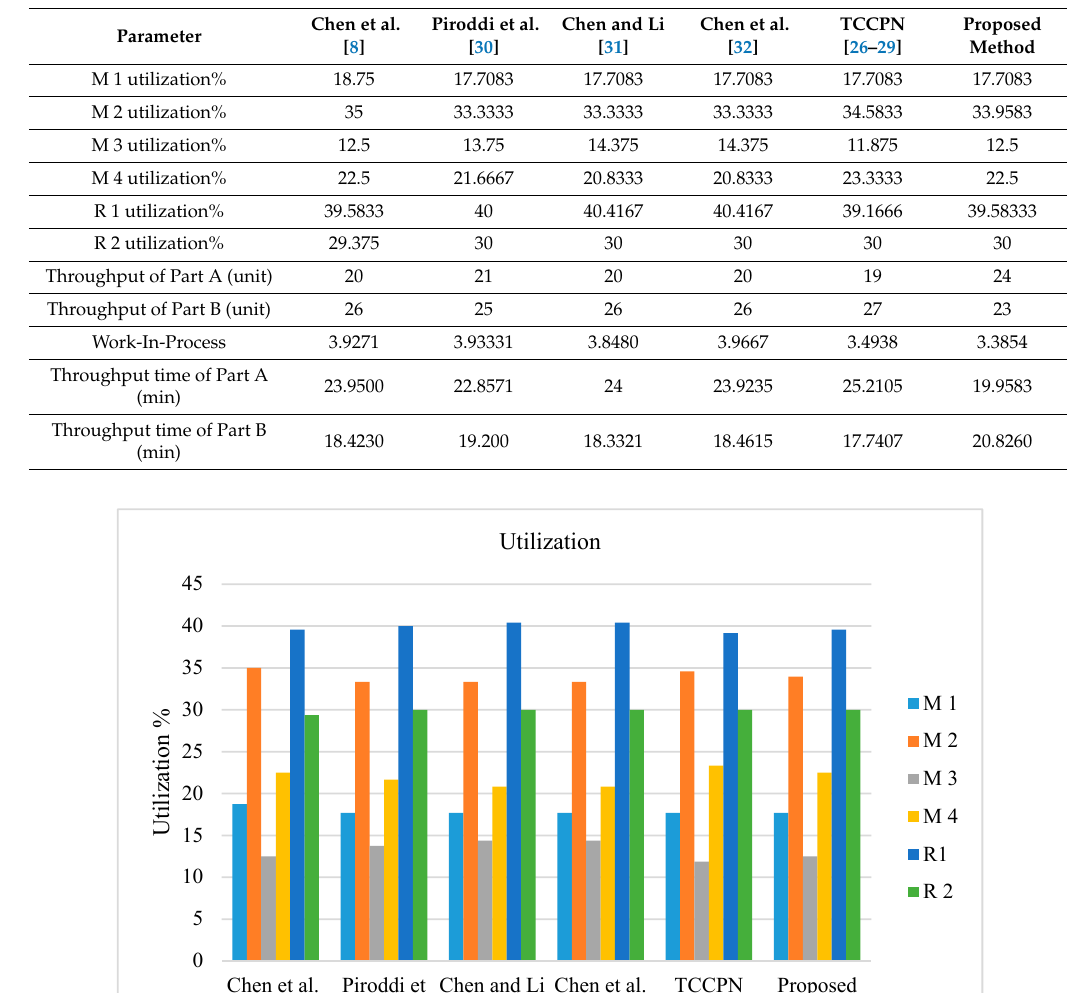
Table 3. Comparison with the existing policies: utilization throughput, work-in-process, and throughput time.